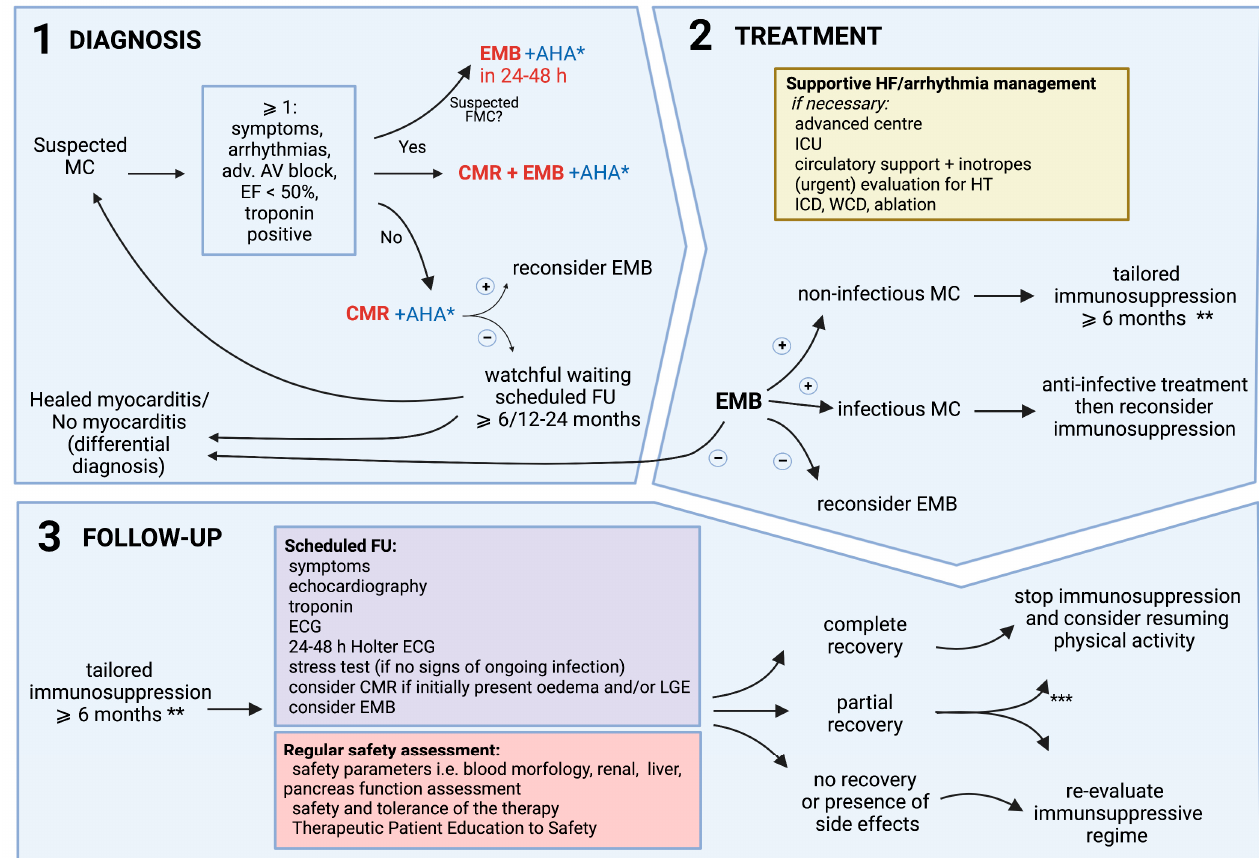
Figure 2. Schematic depiction of a diagnosis, decision-making process, and individualized treat- ment approach for patients with myocarditis. * if available (positive AHA additionally supports the implementation of immunosuppression); ** i.e., type of myocarditis (lymphocytic, eosinophilic, giant-cell), AHA, contraindications (see Table 4 for safety assessments); *** low probability of further improvement, no signs of active inflammation; (+): positive result for myocarditis; ( − ): negative result for myocarditis; AHA: anti-heart autoantibodies; AV: atrioventricular; CMR: cardiac mag- netic resonance; ECG: electrocardiogram; EF: ejection fraction; EMB: endomyocardial biopsy; FMC: fulminant myocarditis; FU: follow-up; HF: heart failure; HT: heart transplant; ICD: implantable car- dioverter defibrillator; ICU: intensive care unit; LGE: late gadolinium enhancement; MC: myocarditis; WCD: wearable cardioverter defibrillator. Created with BioRender.com (accessed on 4 January 2022 ).